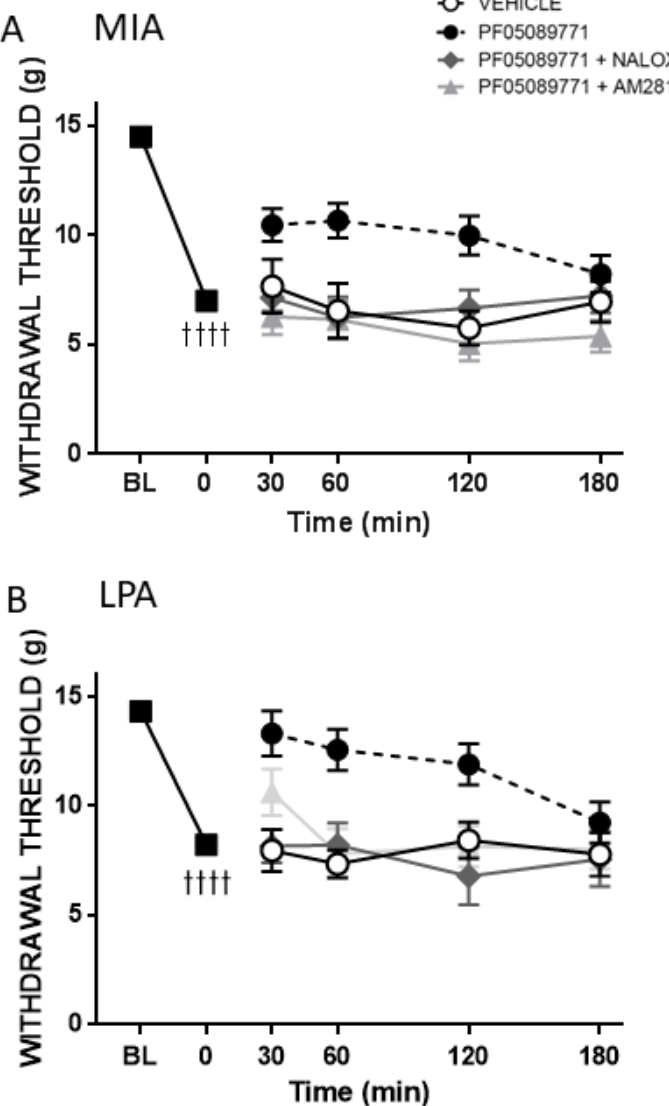
Figure 4. Involvement of the Endogenous Opioid and Endocannabinoid Systems in PF05089771 Responses. Blockade of endogenous opioid receptors with naloxone or CB 1 receptors with AM281 significantly reduced the anti-allodynic effect of PF05089771 in MIA- ( A ) and LPA- ( B ) treated rats. p < 0.05, two-way RMANOVA; †††† p < 0.0001, two-tailed paired Student t -test between baseline (BL) vs. t = 0 min. Data are expressed as mean ± S.E.M ( n = 8–16 animals/group).